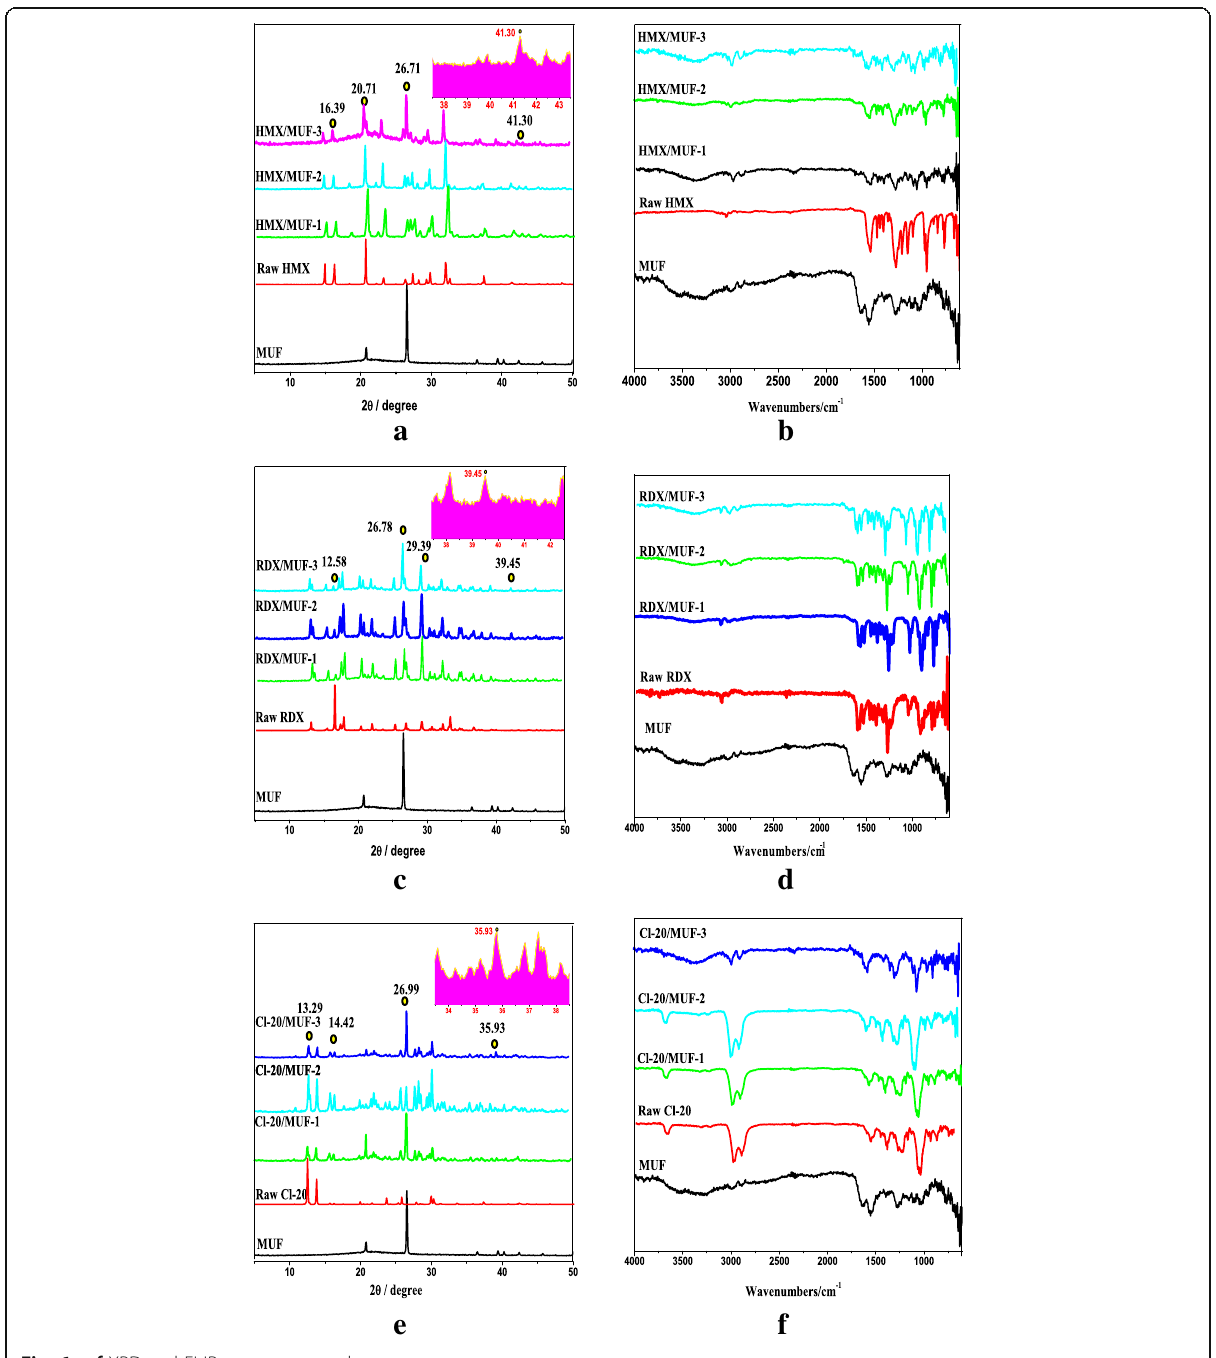
Fig. 6 a – f XRD and FI-IR spectrum